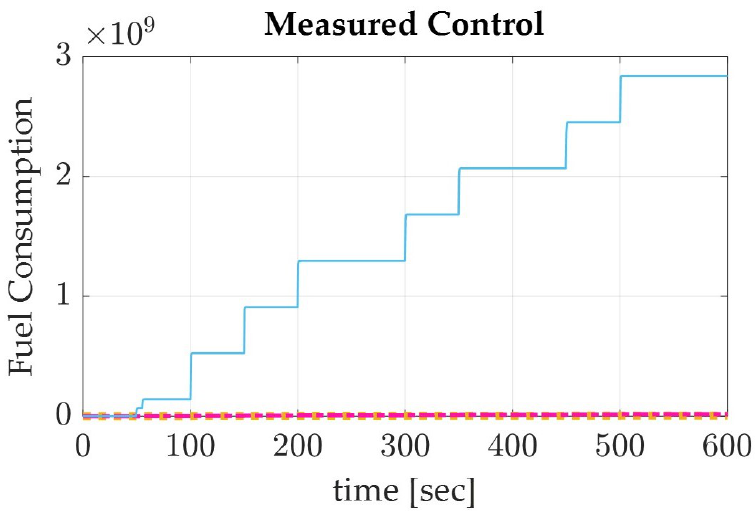
Figure 4. Graph of the Euler angle tracking for a spacecraft de-orbiting from LEO altitude (1000 km) using a sinusoidal autonomous trajectory for roll (yellow), pitch (pink), and yaw (blue).